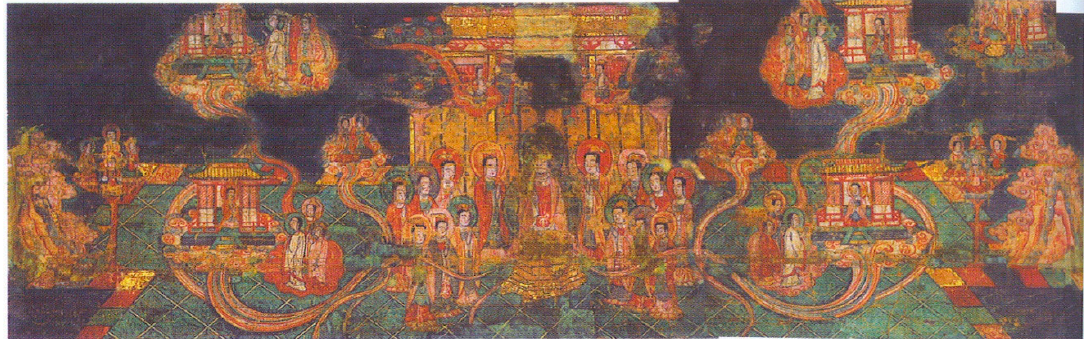
Figure 3. The Realm of Light (Gulácsi 2016, Figure 6/37 [p. 446]).